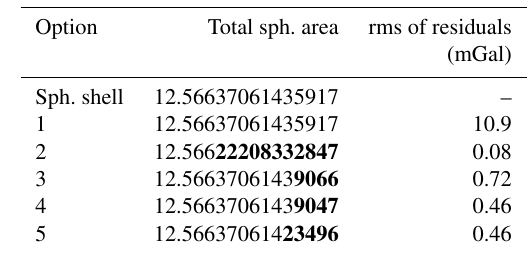
Table B1. Surface element options in terms of the total spherical area and gravity residuals. For option 1 the total area is exact since the triangle area is calculated directly from 4 π . Bold numbers are the significant digits that are different from the spherical shell solu- tion for the various model